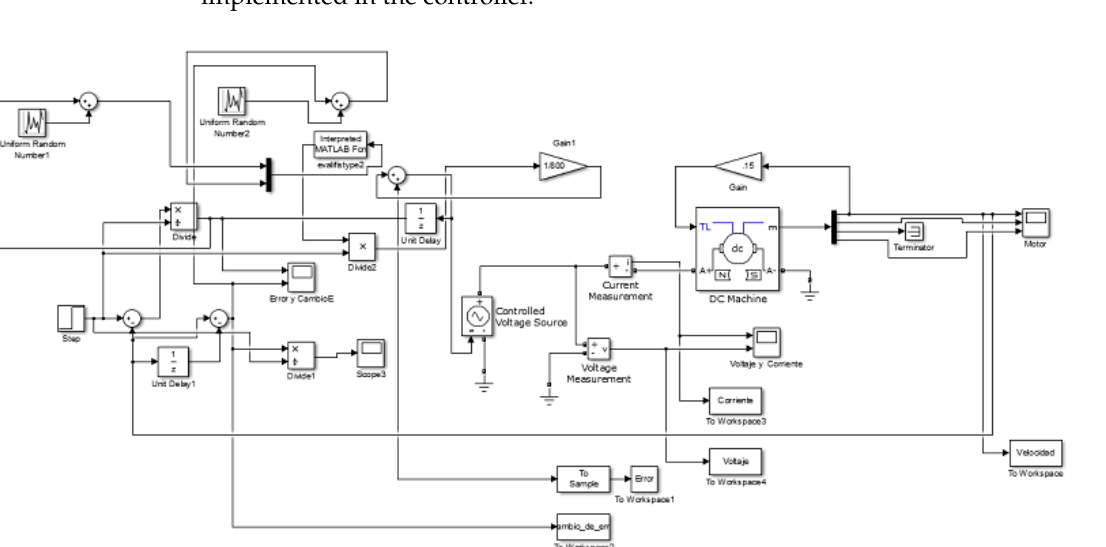
Parameter FHS Harmonies 50 Dimension 90 Iterations 30 Number of experiments 30 HMR harmony memory accepting 0.95 PArate pitch adjustment rate Dynamic